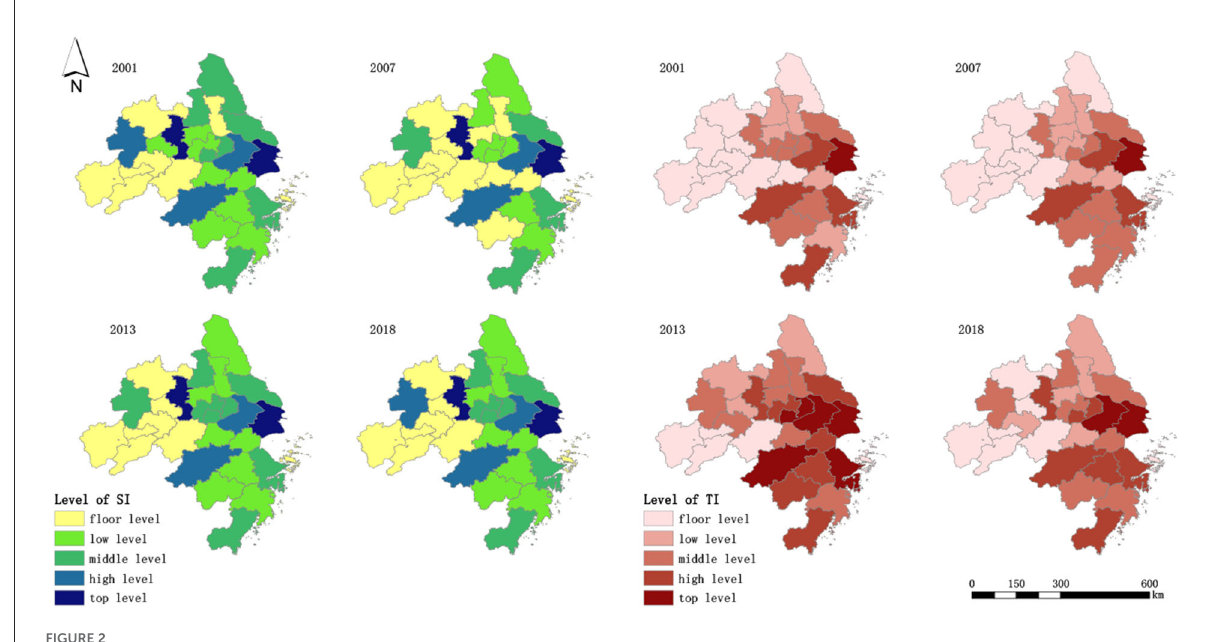
FIGURE2 Spatial distribution of the SI level and TI level.